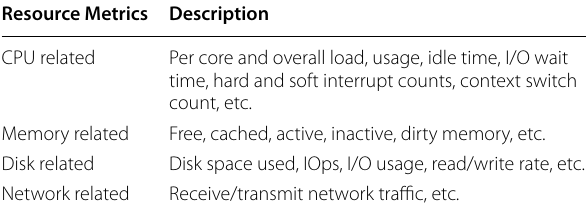
Table 2 Description of system resource metrics Resource Metrics Description